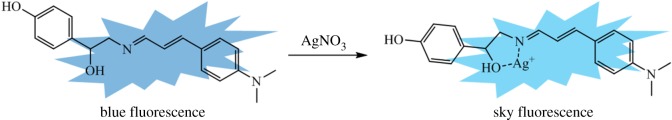
The proposed fluorescent sensing mechanism of Ag+ by 1.